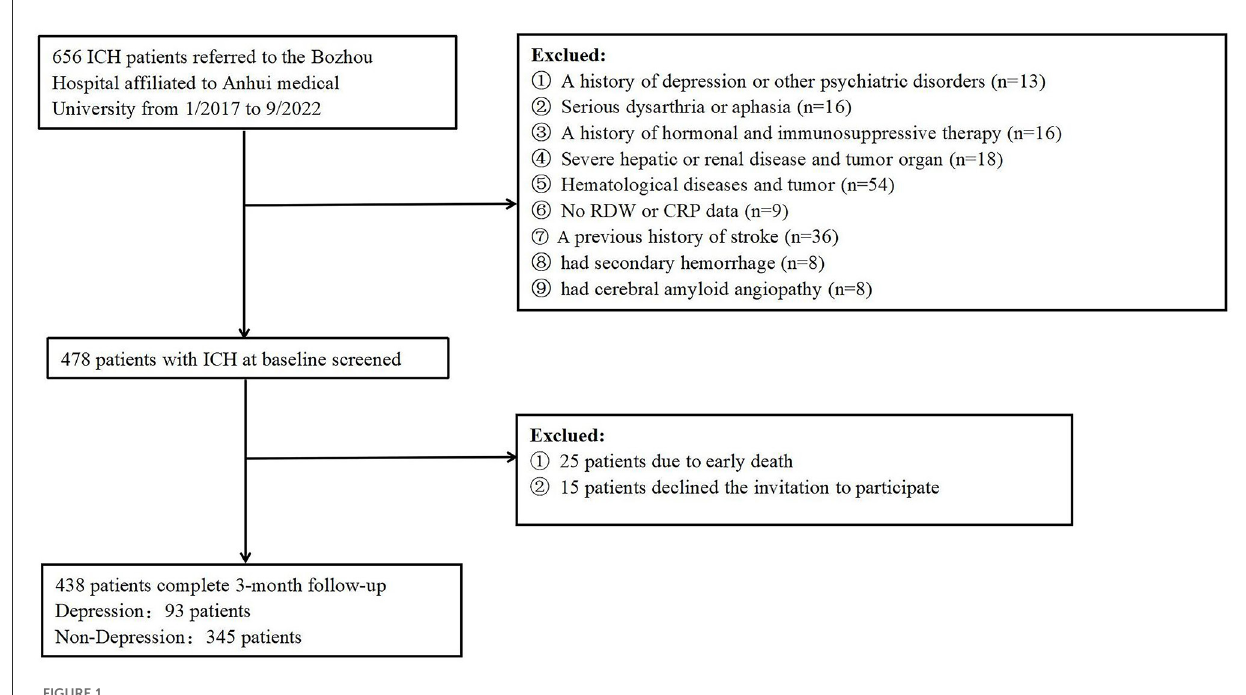
FIGURE1 Flowchart of participant selection.